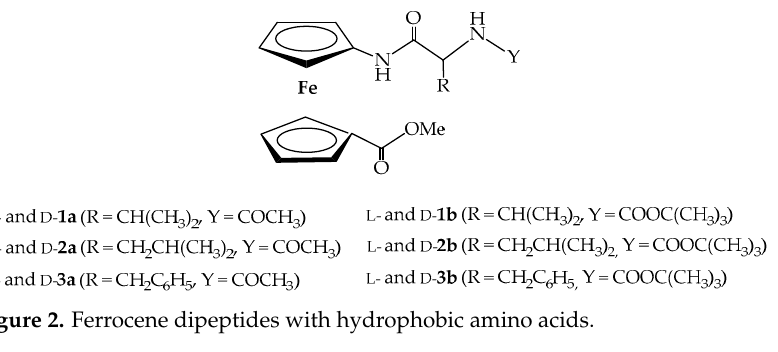
Figure 2. Ferrocene dipeptides with hydrophobic amino acids.